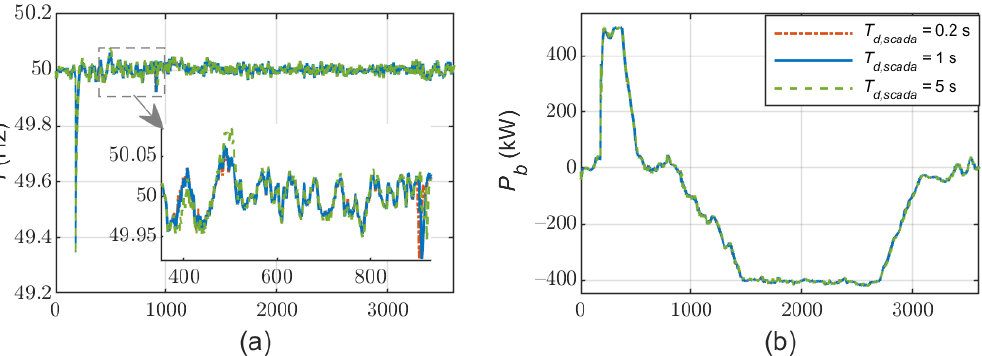
Figure 13. Response following a diesel unit outage at 150 s and synchronization of another at 900 s, for different supervisory control and data acquisition (SCADA) communication delays. ( a ) Frequency, ( b ) BESS active output power (positive: injection, negative: absorption).